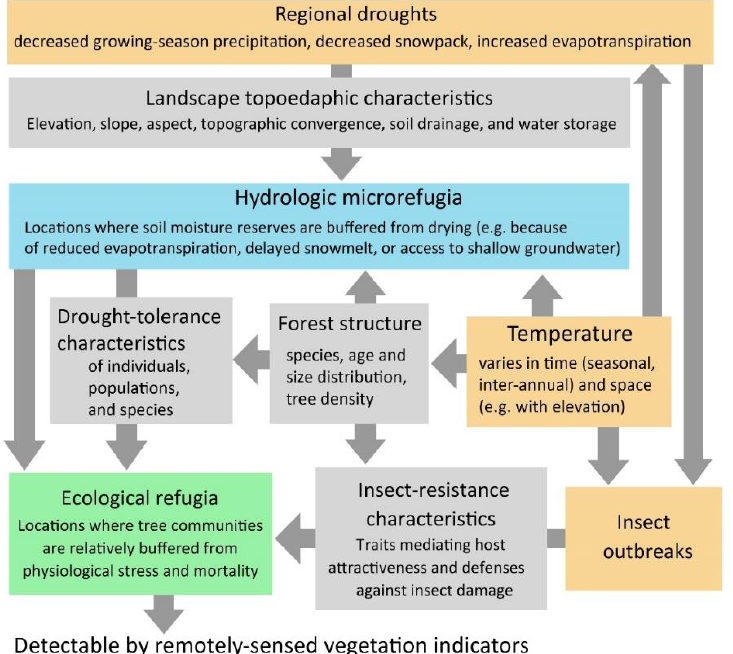
Figure 1. Conceptual diagram of potential factors affecting the presence of refugia in forests during drought–insect disturbances. Orange boxes are “top down” drivers of disturbance dynamics operating at regional to landscape scales. Gray boxes are finer-scale landscape characteristics that produce spatial heterogeneity in soil moisture and ecological conditions including locations of refugia (blue and green boxes). Ecological refugia from disturbance may be supported by interactions between hydrologic refugia and spatial patterns in forest structure, including traits that confer drought and insect resistance.